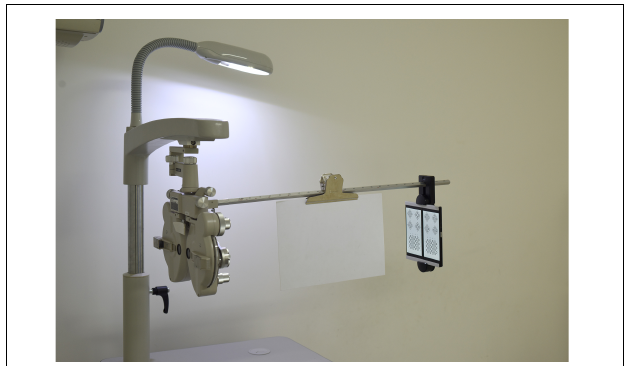
FIGURE 1 | Photograph of the testing system.